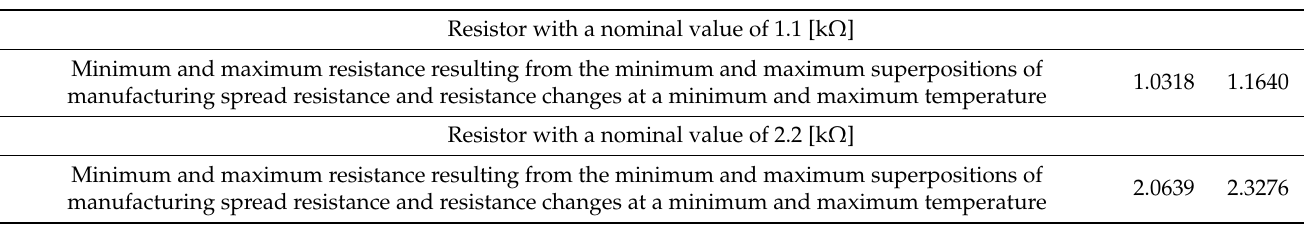
Table 3. Permissible ranges of the resistance achieved by real EOL resistors, taking into account the superposition of most unfavorable